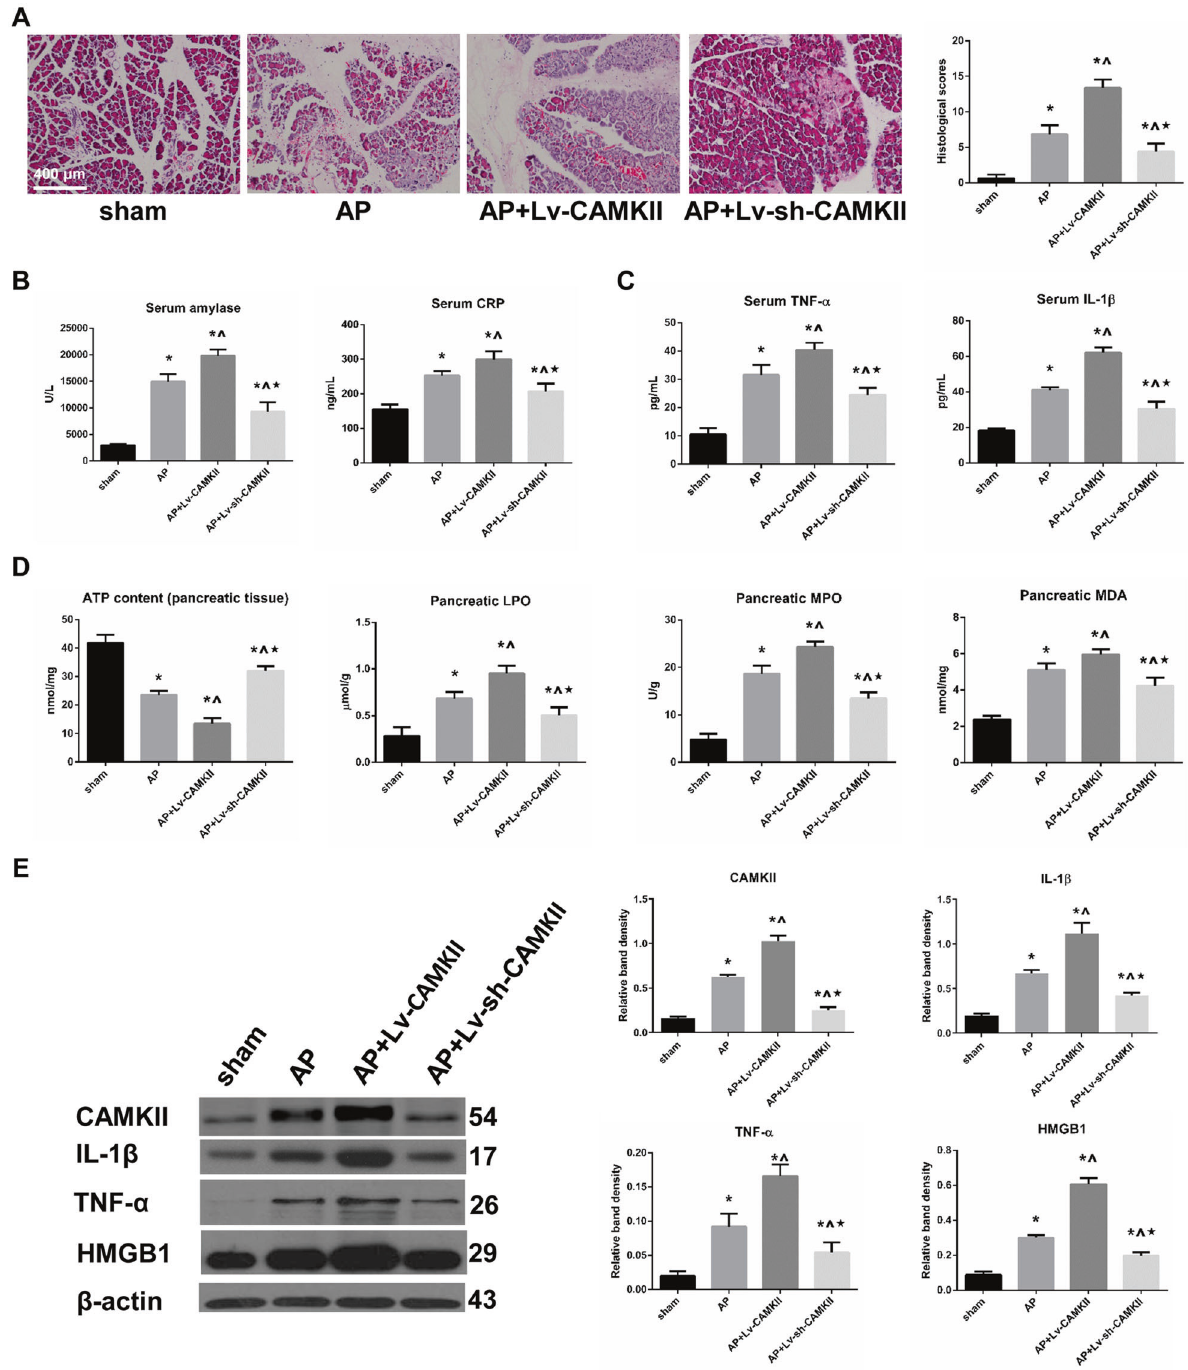
Fig. 1 AP-related necrotic injury was positively regulated by the incubation level of CAMKII. A Representative photographs and histological scores of HE-stained pancreatic sections harvested from the rats that were subjected to sham operation, AP, AP + Lv-CAMKII and AP + Lv-sh-CAMKII for 6 h since AP induction. Bar = 400 μ m. B , C Serum levels of amylase, CRP, TNF- α , and IL-1 β in rats as described above. D Pancreatic levels of ATP contents, LPO, MPO, and MDA in rats as described above. E Representative Western blot images and quanti fi cations of CAMKII, HMGB1, TNF- α and IL-1 β protein expression in pancreatic tissues harvested from the rats as described above. β -actin was used as the protein loading control. Data were presented as mean ± SD ( N ≥ 3). ∗ P < 0.05 versus sham, ^ P < 0.05 versus AP, and * P < 0.05 versus AP + Lv − CAMKII. AP acute pancreatitis, ATP adenosine triphosphate, CAMKII calcium/calmodulin-dependent protein kinase II, CRP C-reactive protein, HE hematoxylin-eosin, HMGB1 high mobility group protein B1, IL-1 β interleukin-1 β , LPO lipid peroxidase, MDA malonic dialdehyde, MPO myeloperoxidase, SD standard deviation, TNF- α tumor necrosis factor- α .